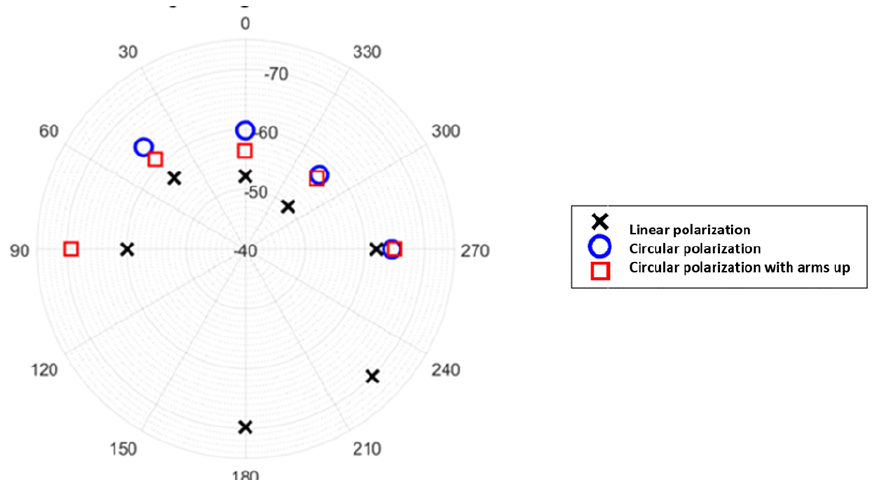
Figure 6. Comparison of measured RSSI values for the tag set in frontal position onto the jacket and read by varying the source